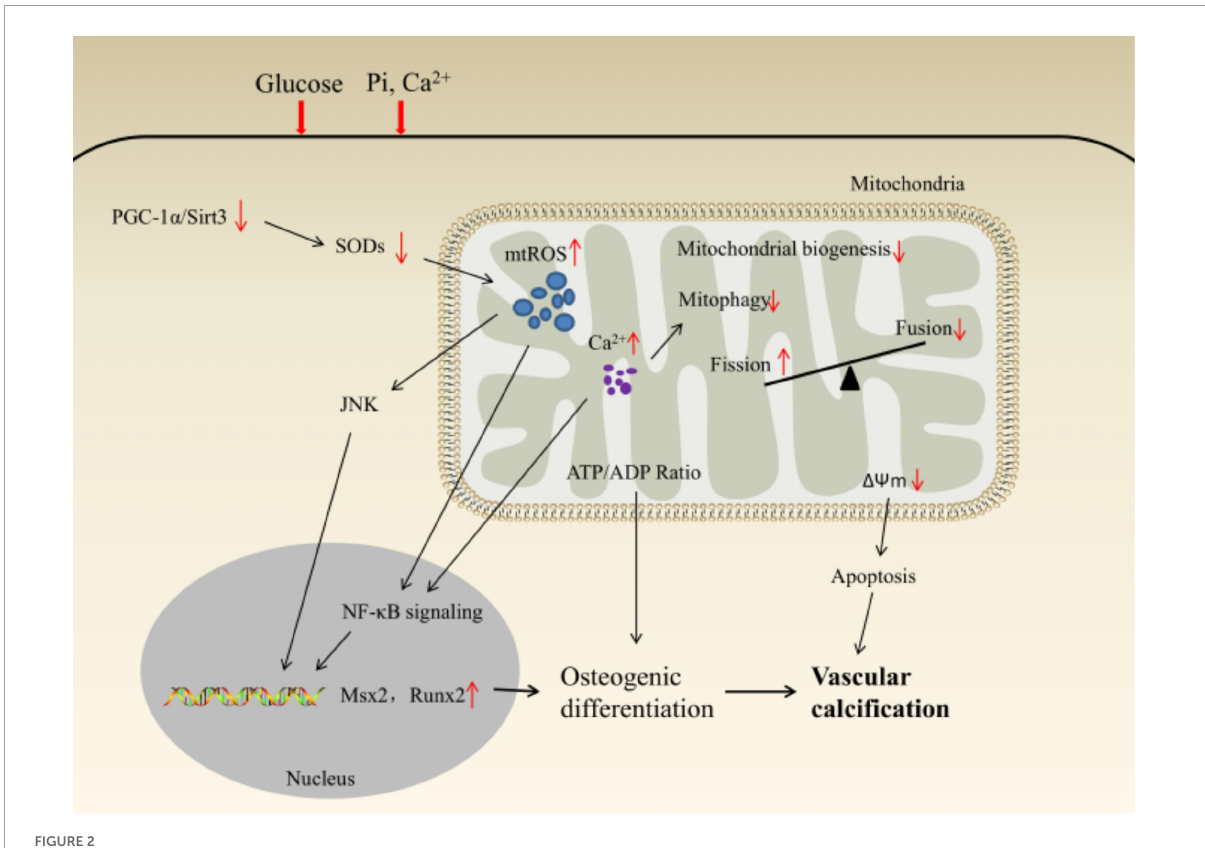
FIGURE2 Schematic illustration of mitochondrial homeostasis and VSMCs phenotypic